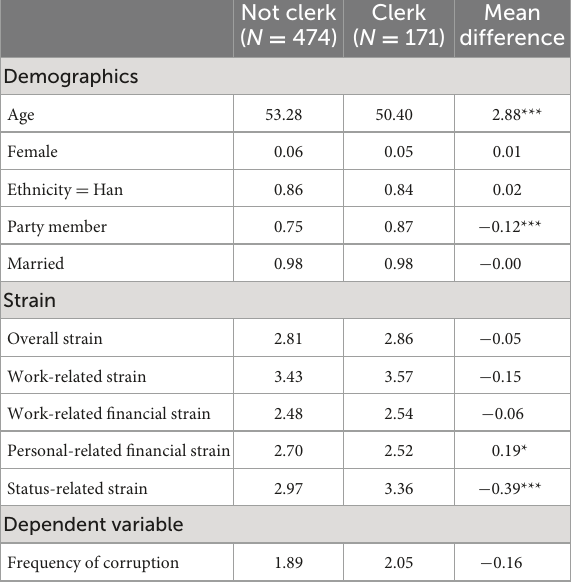
TABLE 2 Two independent sample t -tests between clerk and non-clerk